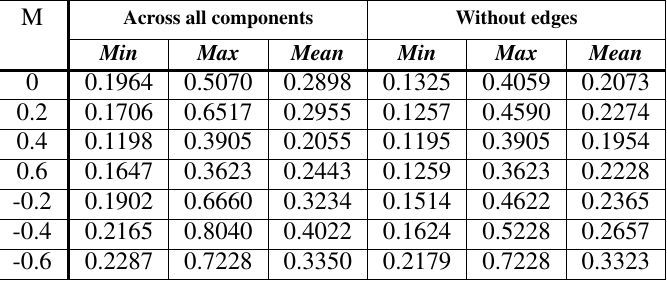
TABLE II. Relative Maximum Absolute Deviation – using WPT